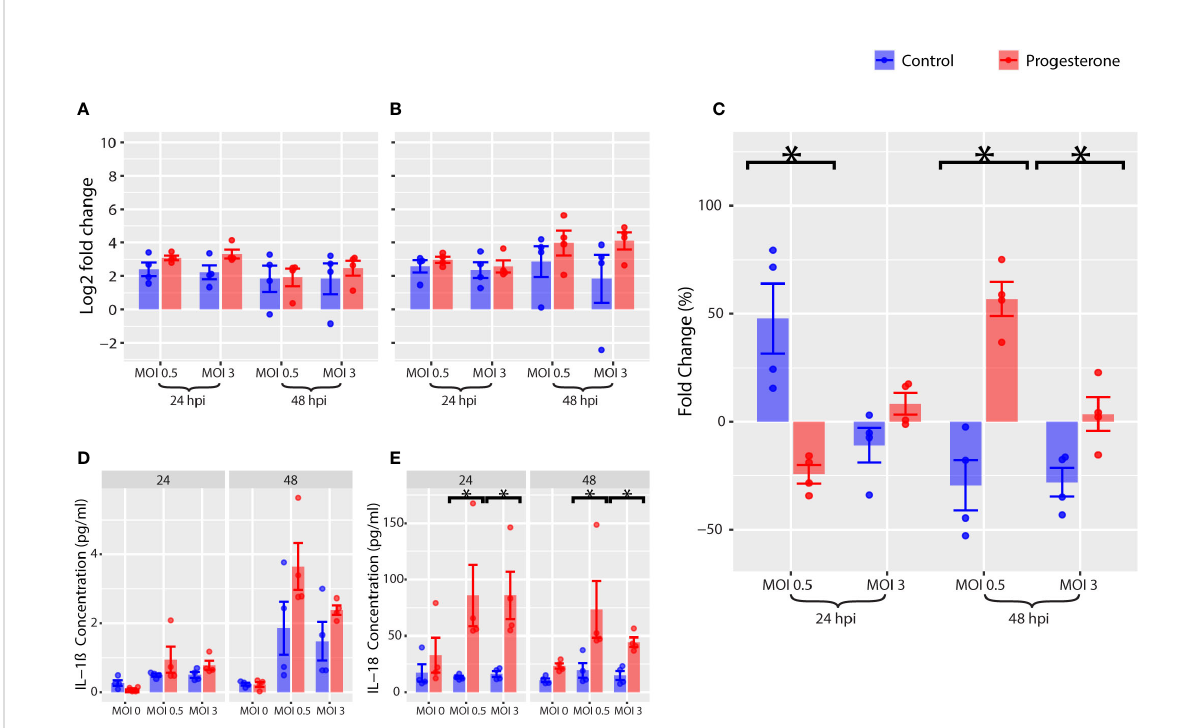
FIGURE 3 NLRP3 in fl ammasome activation in Calu-3, a lung cell line. Various markers of the NLRP3 in fl ammasome pathway were measured in Calu-3. Gene expression of IL1B (A) and NLRP3 (B) were measured by RT-qPCR. As a marker for NLRP3 in fl ammasome activation, caspase-1 activity was measured (C) . Luminex multiplex assays were used to measure the change in concentration of IL-1 b (D) and IL-18 (E) over time. *p-value was less than 0.05, as determined by the statistical analysis detailed in the Methods